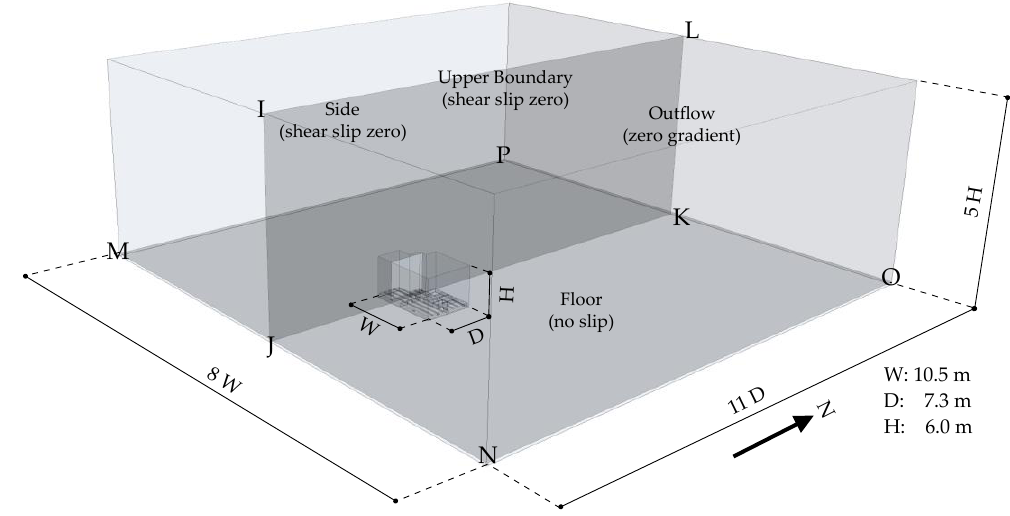
Figure 5. Residential building and control volume for calculating the ventilation rate in sub floor ventilation area.